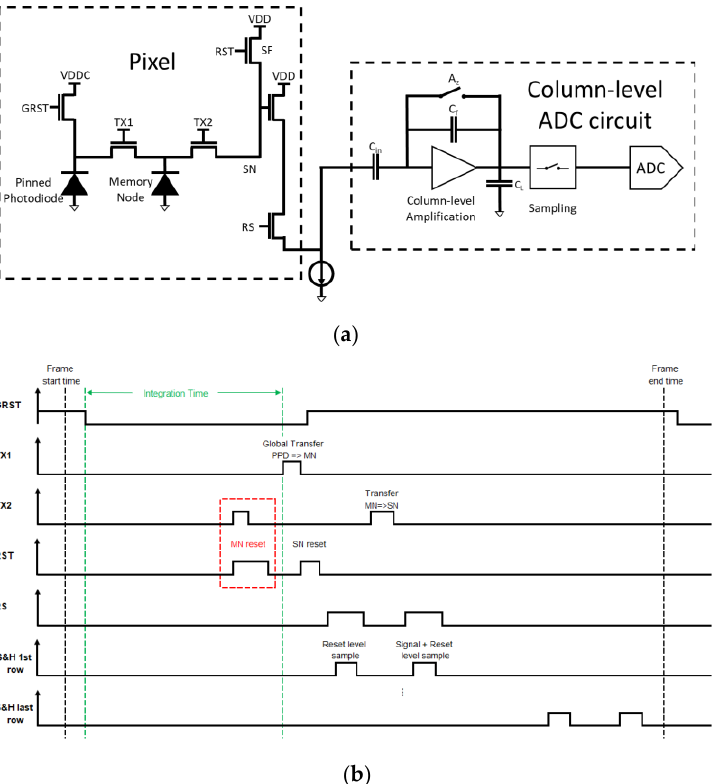
Figure 2. ( a ) Schematic presentation of a 6T APS, including the Global Reset Shutter (GRST), the transfer gate TX1 to the memory node (MN) and the additional transfer gate TX2 to the sensing node (SN). The reading of the signals with the source follower then follows exactly as in the four-transistor-APS (of Figure 1). The column-level ADC circuit is presented schematically. ( b ) Timing diagram of 6T APS, including the Global Shutter (GRST) and true Correlated Double Sampling (CDS).